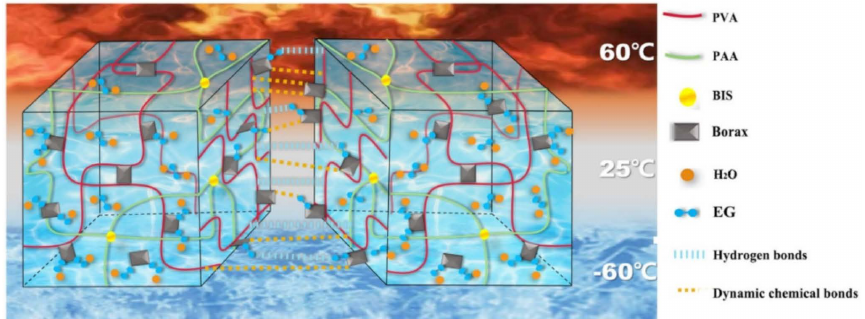
Figure 46. Self-healing mechanisms of the gel. Reprinted with permission from [212]. Copyright (2020) American Chemical Society.